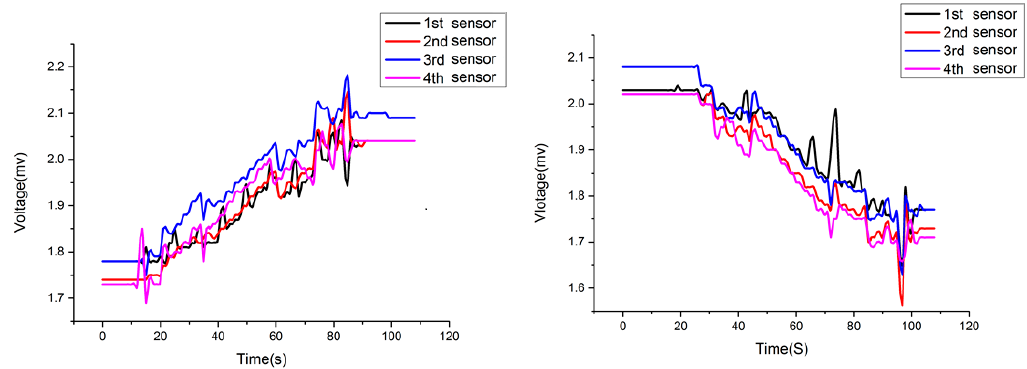
Figure 21. Tension curves of four wire ropes under normal condition.